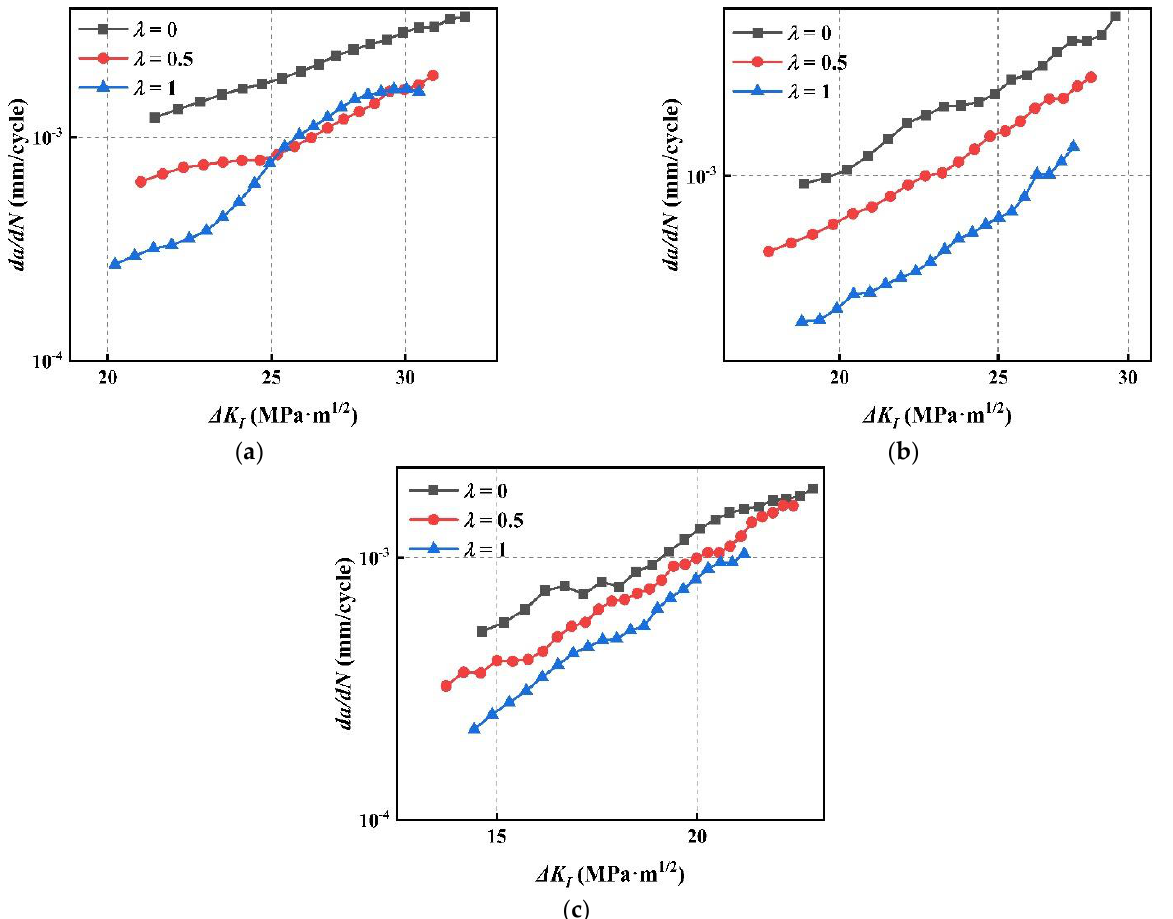
Figure 12. Where β = 60°, the relationship between FCGR and ∆ K I under different stress ratios ( a ) R = 0 ( b ) R = 0.1 ( c ) R = 0.3.